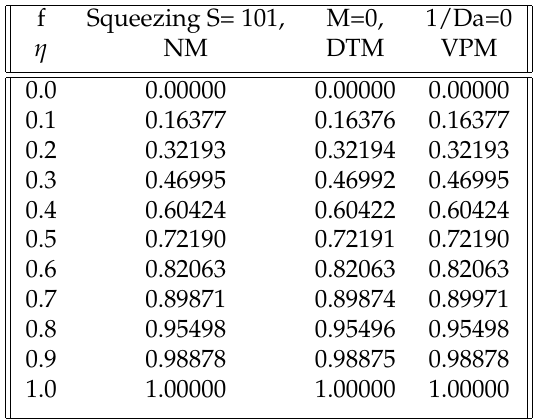
Table 3. Comparison of results of flow for large squeezing number in the absence of magnetic